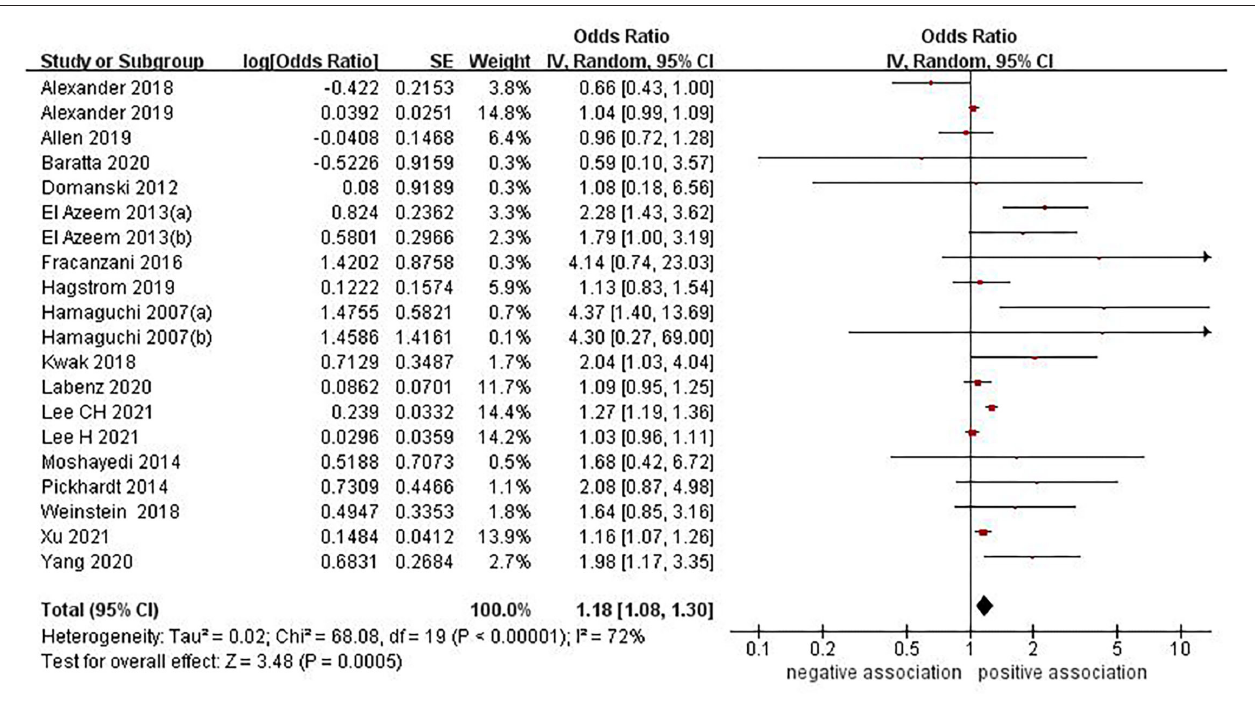
FIGURE 2 | Forest plot of evaluating the association between NAFLD and